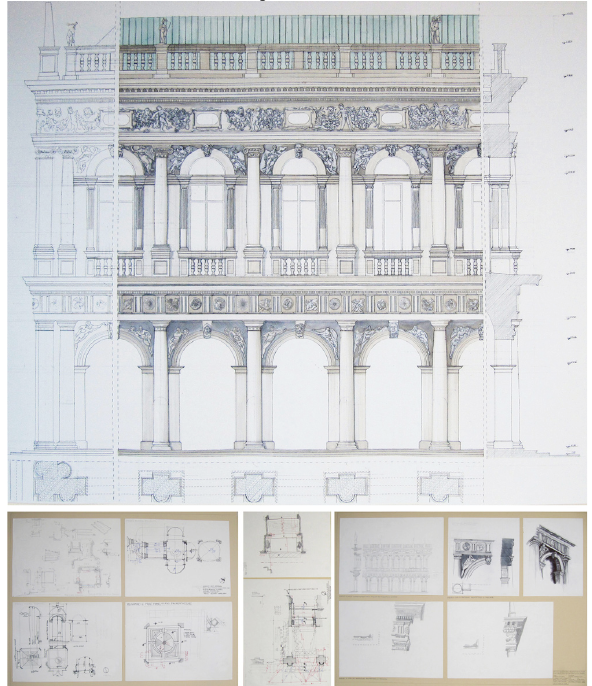
Figure 6 - Collection of perceptual, visual, metric